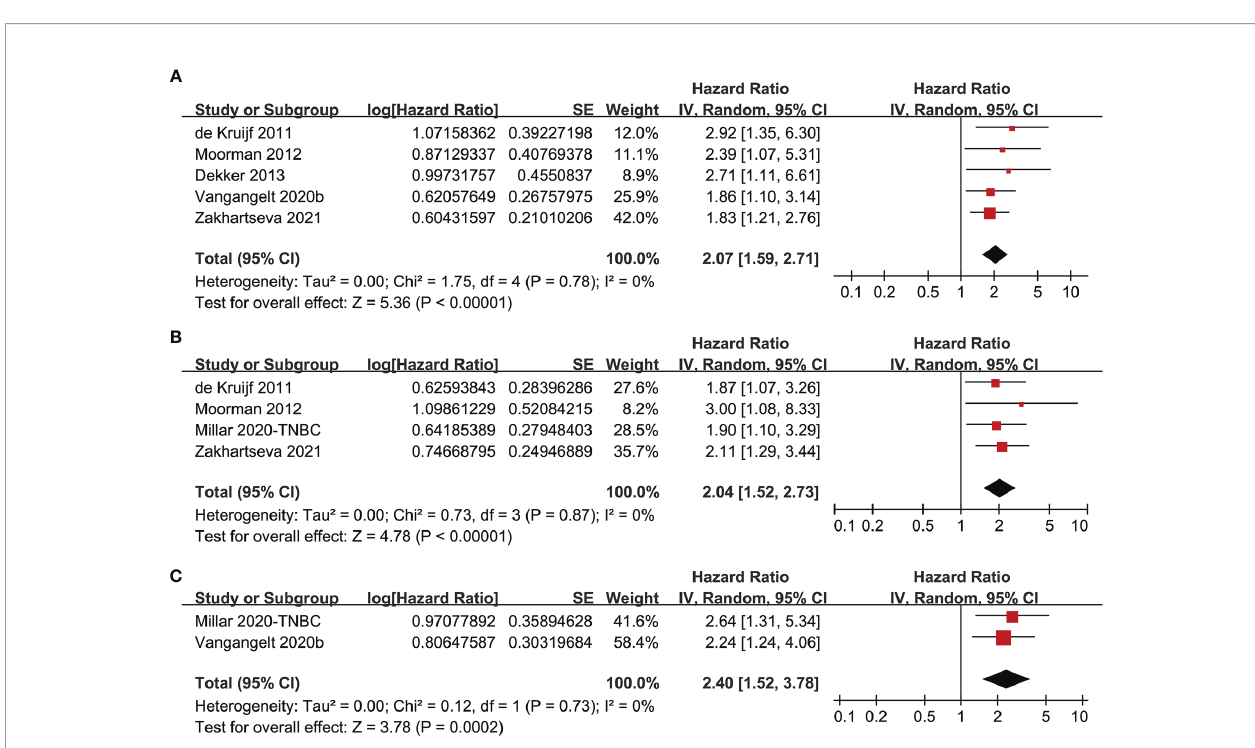
FIGURE 3 | Forest plots for the meta-analysis of the association between TSR and survival in women with TNBC; (A) , association between TSR and DFS in women with TNBC; (B) , association between TSR and OS in women with TNBC; and (C) , association between TSR and CSS in women with